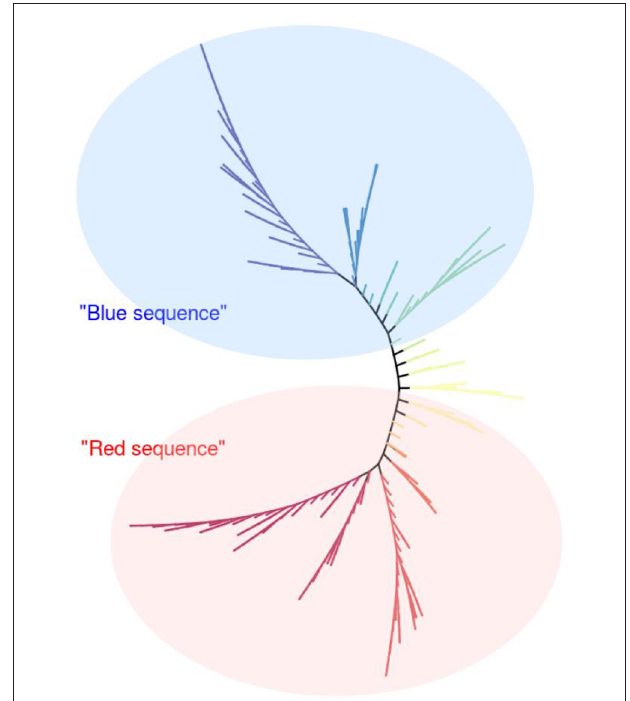
FIGURE 6 | The phylogenetic tree for the galaxies of the WINGS survey. Colors mark the different groups defined by the cladistic analysis on a set of parameters which includes color index, absolute magnitude, effective radius, sersic index, among others. From Fraix-Burnet et al. (2017).